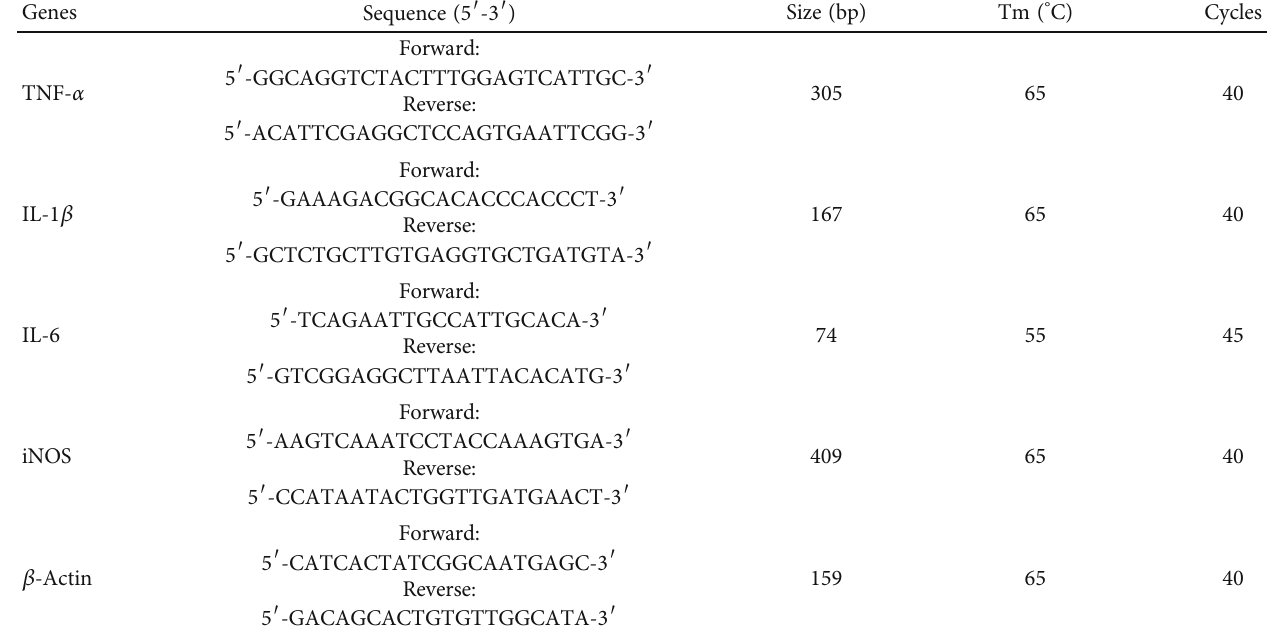
Table 1: Primer sequences used for real-time polymerase chain reaction and conditions for detection of proin fl ammatory gene expression. Genes Sequence (5 ′ -3 ′ )